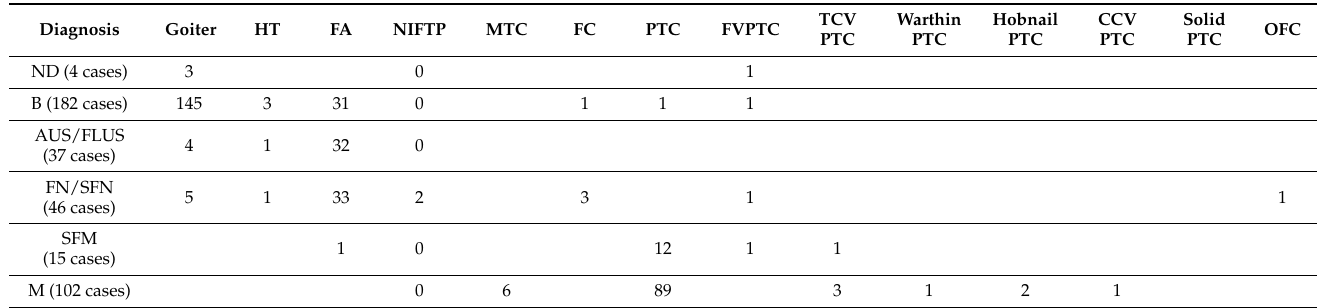
Table 4. Cytologic/histological correlation for the centimeter series of